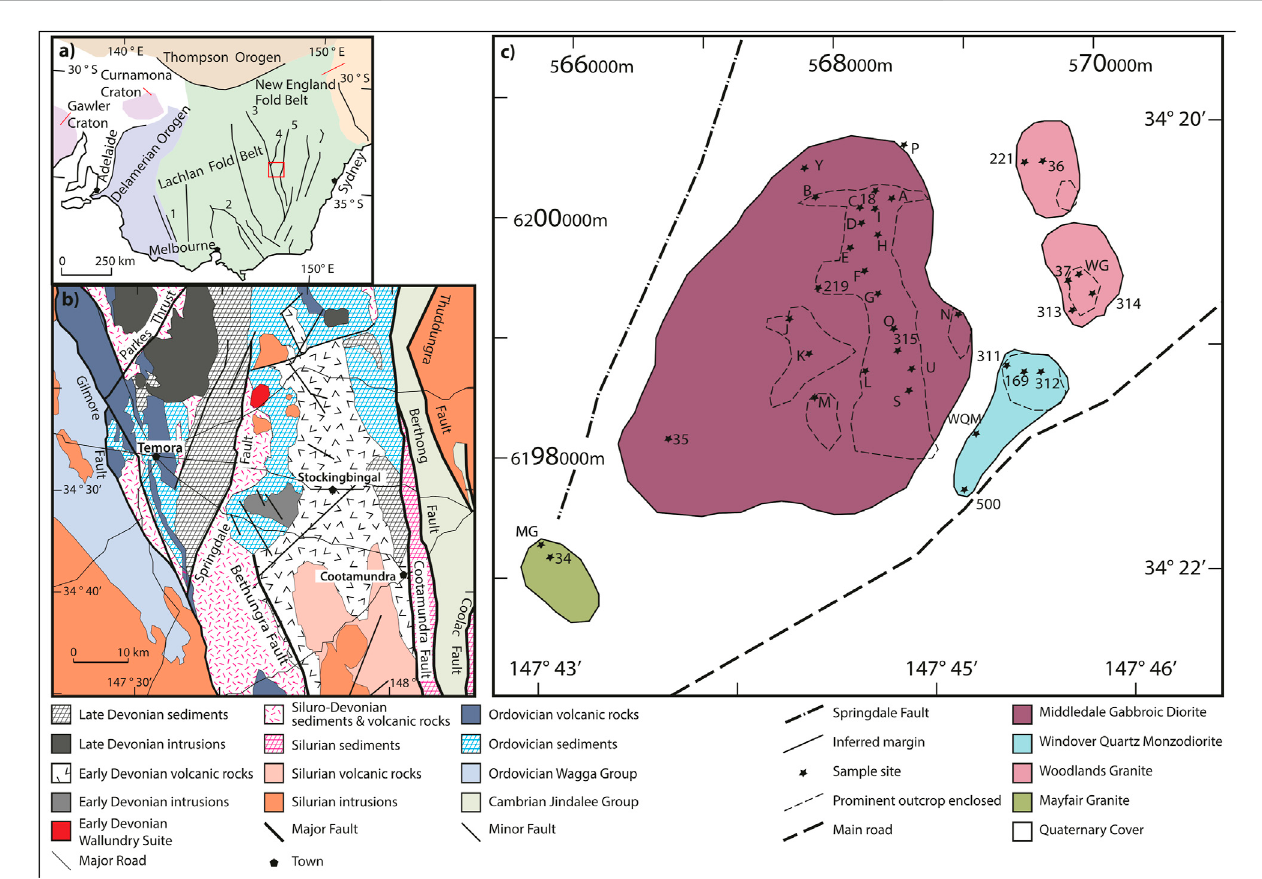
FIGURE 1 Map of theWallundry Suite, the regional geology and the broad geological setting with southeastern Australia (modi fi edafter Figure1 of Iles et al., 2015). (A) Mapoftheorogeniczones ofsoutheasternAustralia, includingtheLachlanFold Belt,which isdivided into theWestern,Centraland Eastern Lachlanbythe Stawell-Ararat Fault Zone (1), the Governor Fault Zone (2) and the Gilmore Fault Zone (3). The Parkes Thrust (4) and the Coolac-Narromine Fault Zone (5) bound the region outlined in red, which is expanded in (B) to show the regional geological setting of the Wallundry Suite. (C) Map of the Wallundry Suite, showing the sample sites from this study (A-P, S, U, Y, WG, WQM and MG) and those from Wormald (1993; numbered sites). The TEMORA 1, two and three sample sites are located to the north of Site A, the east of Site B and the north-east of Site A, respectively, although these boulders are not in situ